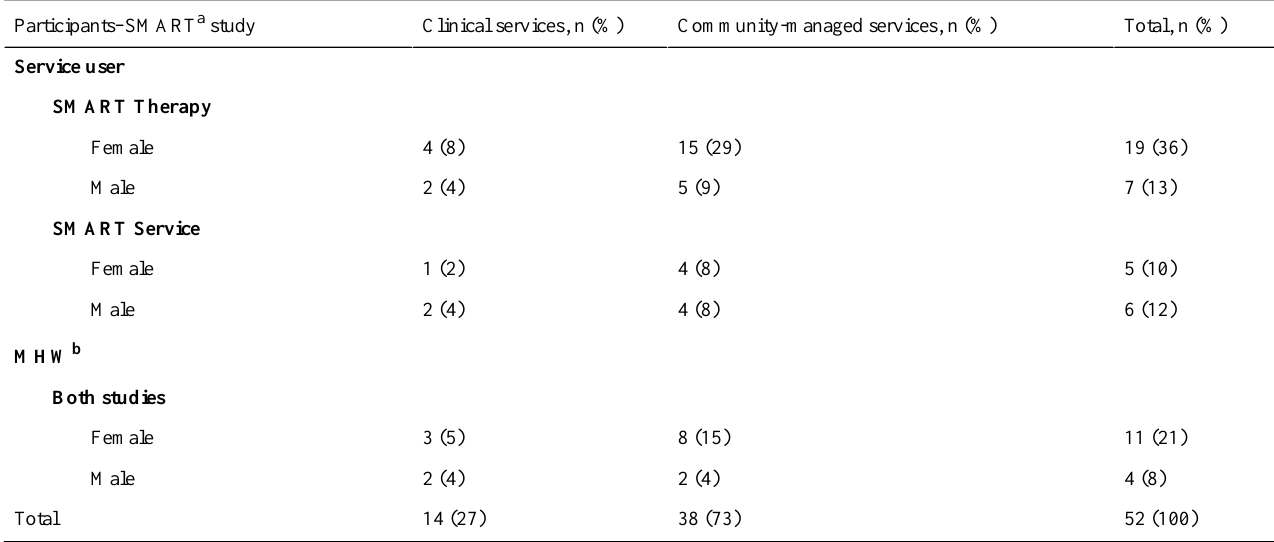
Table 1. Participant recruitment